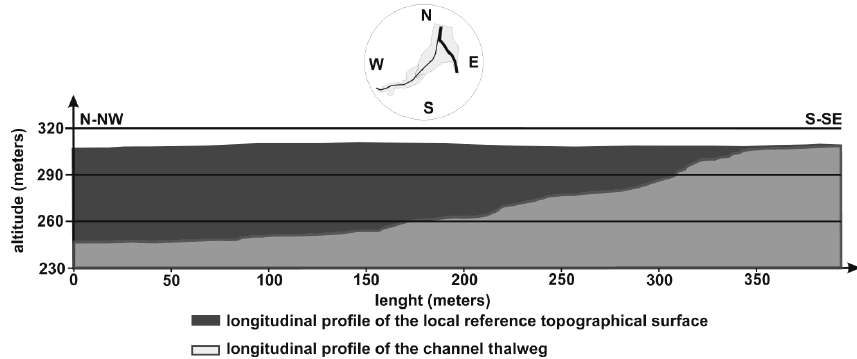
Fig. 11. Longitudinal profiles of surface and river bed Cucuteni-Baiceni side gullies in 2008.